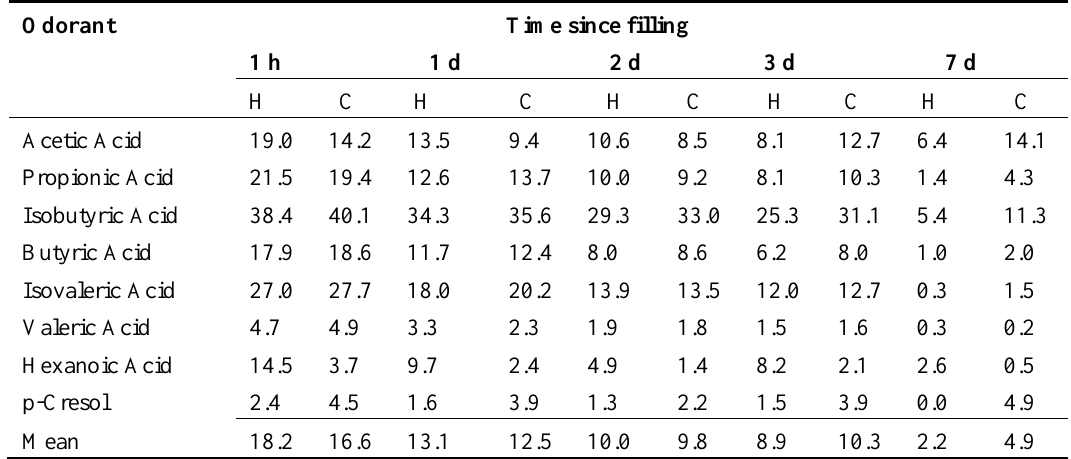
Table 3. Percent recoveries of VOCs in homemade (H) and commercial (C) Tedlar PVF bags filled with the VOC standard gas mixture.